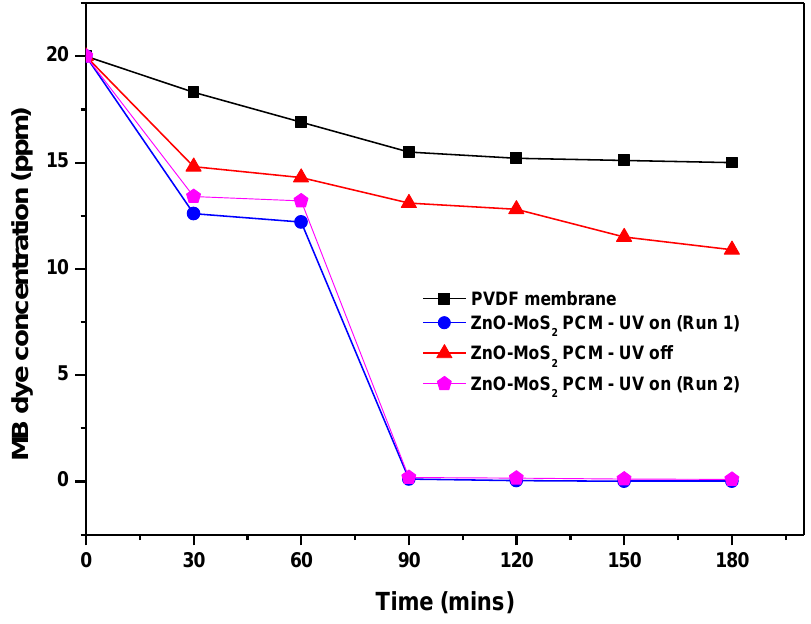
Figure 13. MB dye rejection studies on PVDF and the ZnO-MoS 2 PCM.